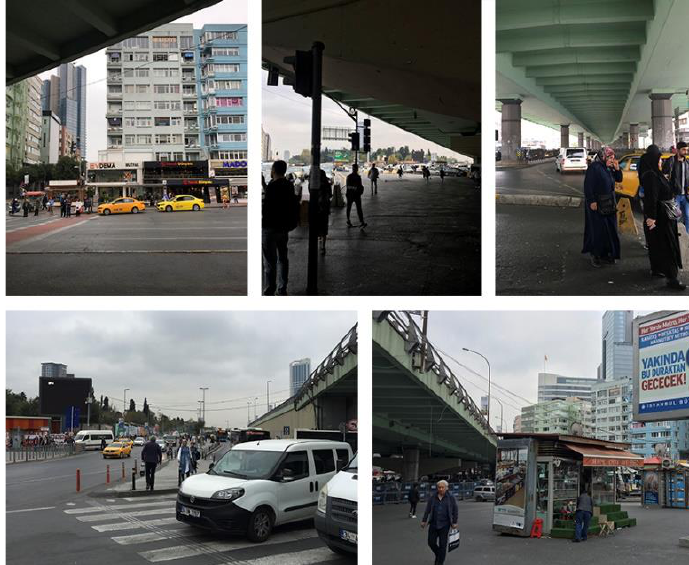
Figure 4 The lack of publi c spaces in Mecidiyeköy (Photograph credits: personal archive of Feride Gül Keleş, 2019) .